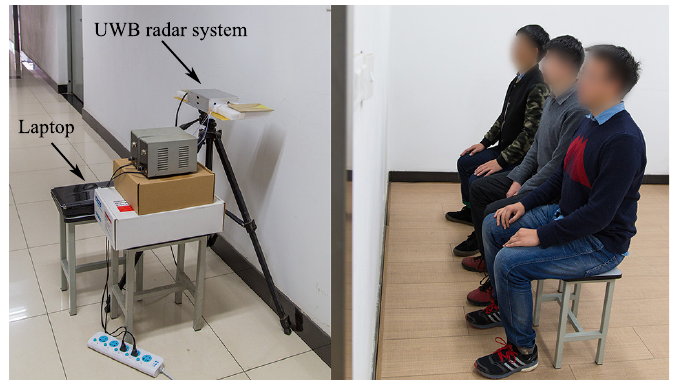
Figure 4. Experimental